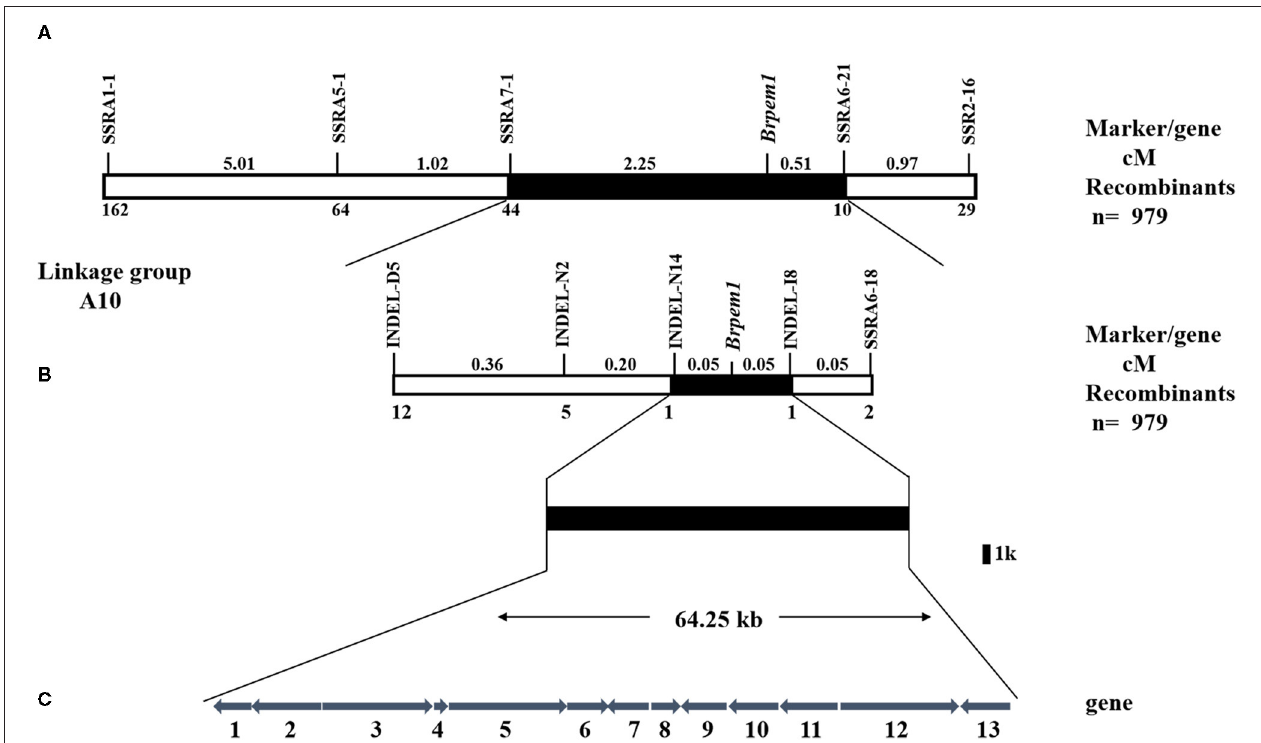
FIGURE 5 | Genetic and physical maps of Brpem1 gene locus and candidate gene analysis of B. rapa . A genetic linkage map of chromosome A10 was constructed, using 979 F 2 recessive individuals with a pale green phenotype. (A) Brpem1 initially located between molecular markers SSRA1-1 and SSRA2-16 in the A10 linkage group. (B) Brpem1 fine mapped to the 64.25kb region on chromosome A10 between INDEL-N14 and INDEL-I8. Numbers of recombined individuals between Brpem1 and the marker are shown at the bottom of the linkage map. Number (cM) at the top of the linkage map, genetic distance between two adjacent markers. (C) The candidate region of Brpem1 and 13 predicted genes (http://brassicadb.org/brad/datasets/pub/Genomes/Brassica_rapa/V3.0/). Numbers 1–13, order of genes in the candidate region; arrows, direction of gene expression. Supplementary Table S3 shows details of these